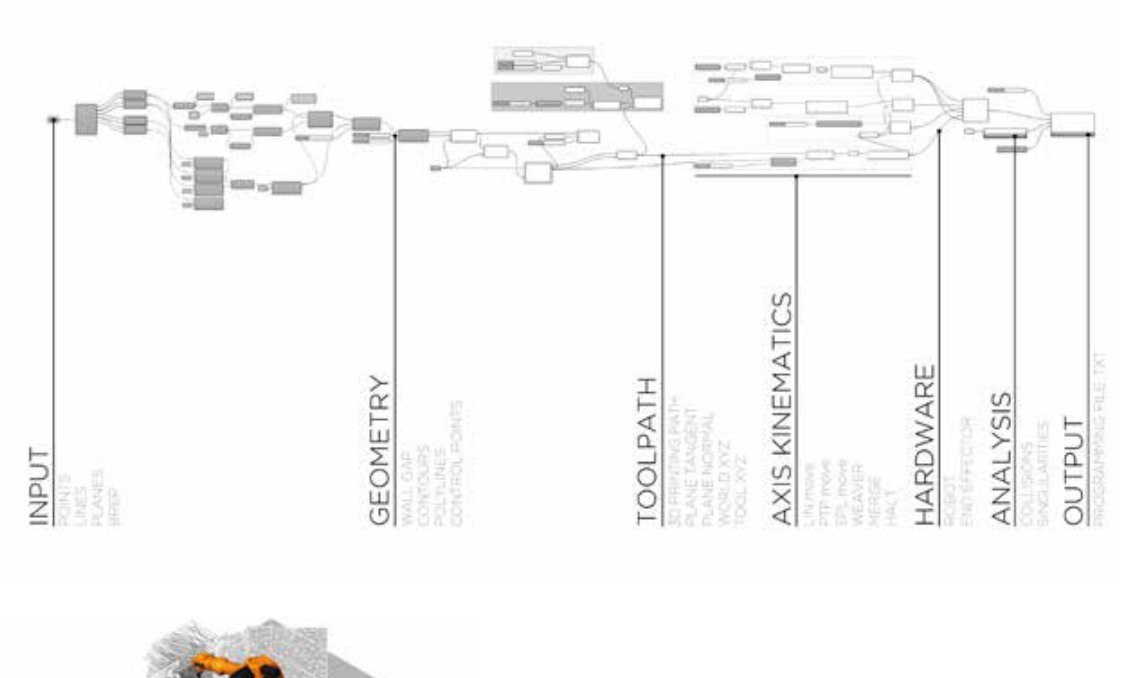
Figure 9 (below): Video frame images of the robot inte- racting with simple geometrical constraints generated by two vertical surfaces. This was an early stage before adding levels of complexity to the experiment. Source: author